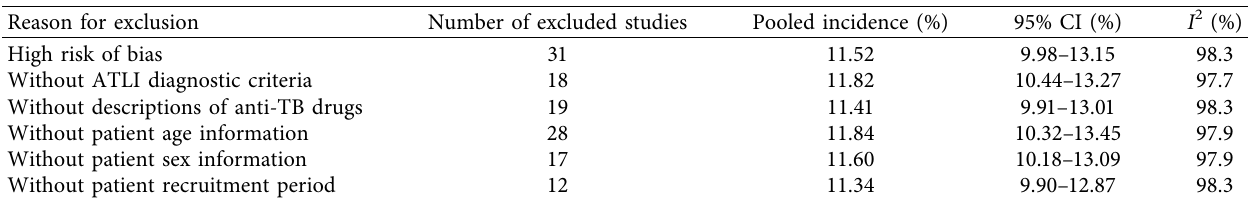
Figure 4: Temporal trend of the pooled incidence of ATLI worldwide (ATLI, antituberculosis drug-induced liver injury). Table 2: Sensitivity analysis of pooled ATLI incidence after the exclusion of some